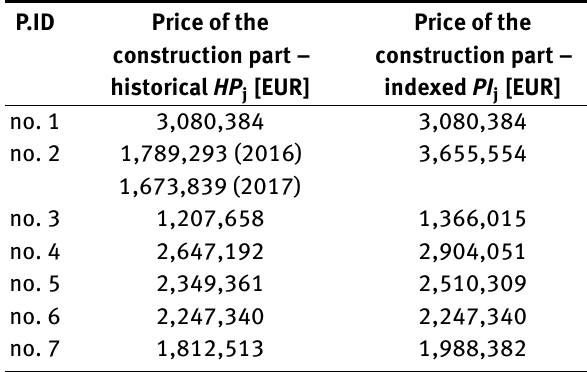
Table 4: Indexing of historical prices for the base